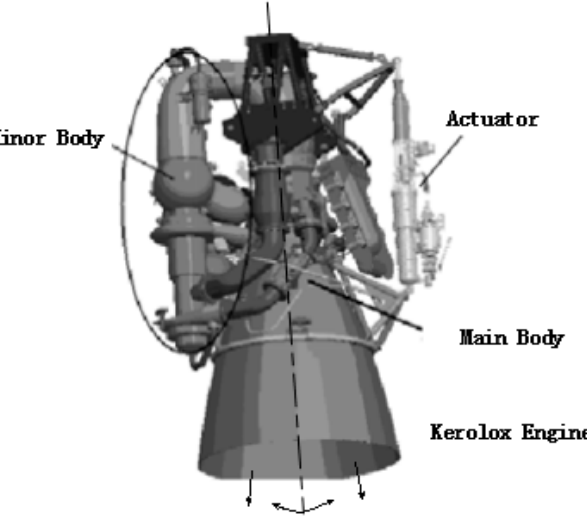
Figure 1. The assembly of the actuator and the driven kerolox engine. A simplified schematics of the electro-hydraulic actuation system is described in Figure 2, where Q L is the load flowrate from the servo-valve to the actuator, P L is the differential pressure across the piston, A p is the acting piston area, X c is the normalized command signal, X p is the piston position, and X L 1 is the normalized load position output of the main body in the equivalent linear form. Usually, the engine gimbaling angle is not measured in flight but in ground tests in the form of linear displacement which is converted to the angular value. The control loop includes a digital controller, a servo-valve, a double acting piston actuator and a linear displacement sensor embedded inside the rod. The controller closes the negative feedback loop and performs digital algorithms for static and dynamic com- pensations. The expected output is the engine’s gimbaling thrust vector angle, i.e., X L 1 . It is a classic aerospace actuator design, where the feedback signal is picked up via the sensor inside the piston rod rather than via the angular output sensor